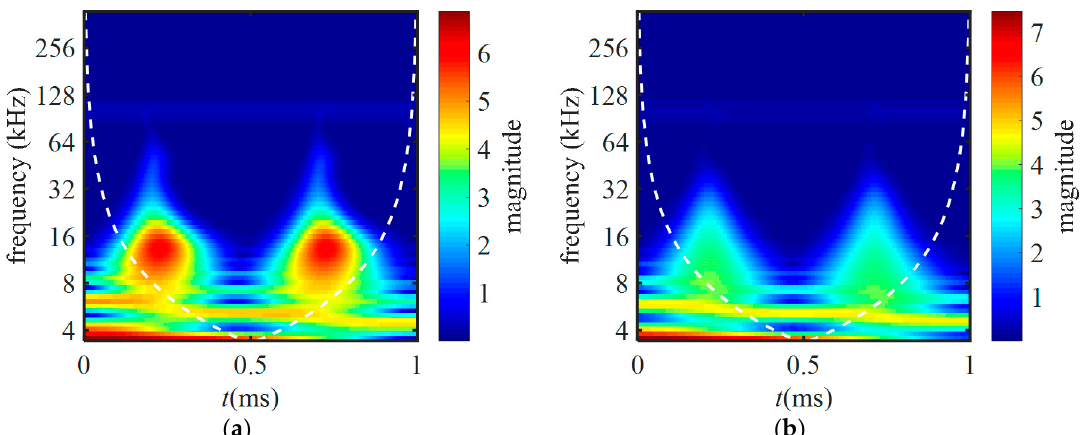
Figure 12. Experimental magnitude scalogram of GaN class-D amplifier: ( a ) open-loop; ( b ) with FFDISM controller.